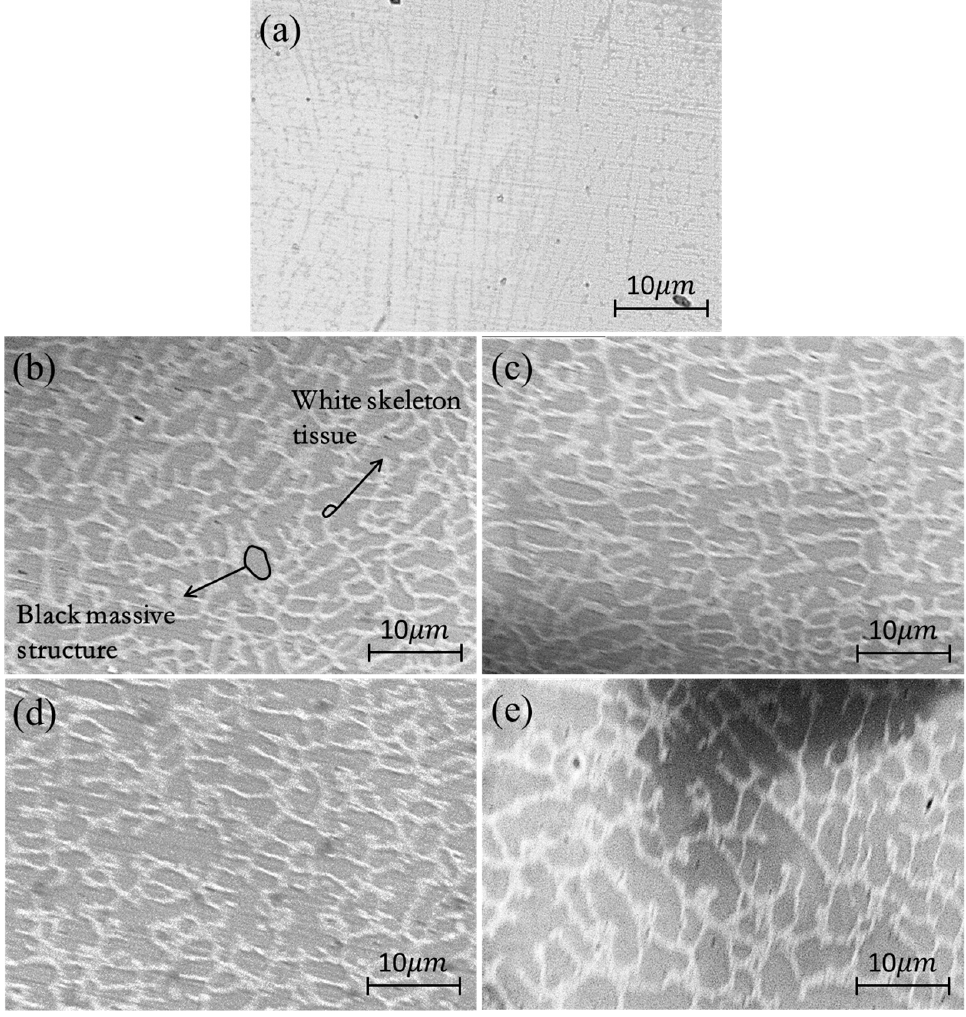
Figure 6. Microstructure and morphologies of ( a ) Sn 0 , ( b ) Sn 0.1 , ( c ) Sn 0.2 , ( d ) Sn 0.3 , and ( e ) Sn 0.5 alloy coatings.